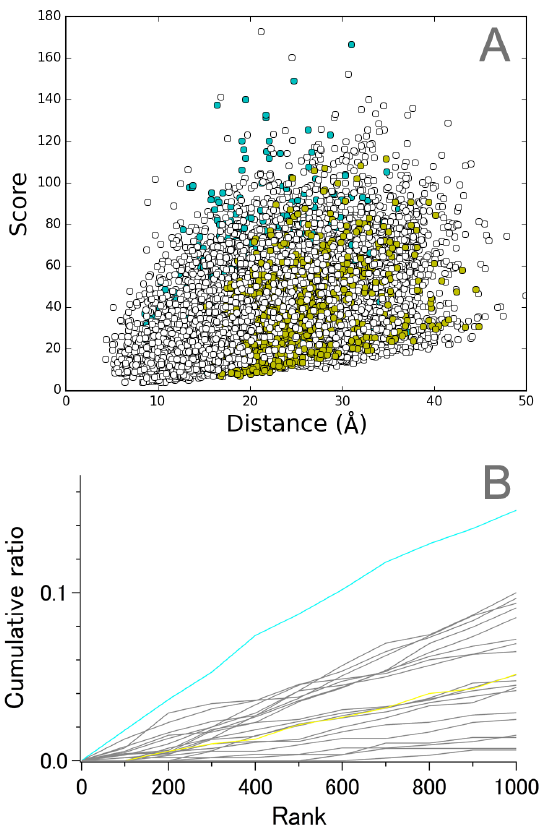
Figure 5. DSA results on 12,373 interhelical pairs in set 3. A . Correlation between score and the average distance. B . Cumulative ratio of the number of C −C pairs in the top-ranked 1,000. The pairs α α are colored as follows; cyan, C-G; yellow, E-G; gray, others.